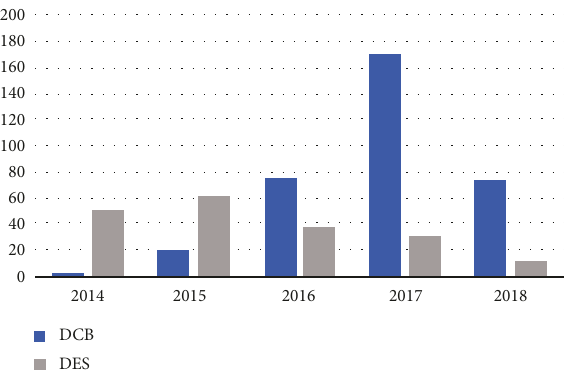
Figure 4: Type of intervention performed by year. There was a paradigm shift for peripheral vascular intervention starting in 2016 from primarily DES placement to mostly DCB usage. DCB � drug- coated balloons; DES � drug-eluting stents.